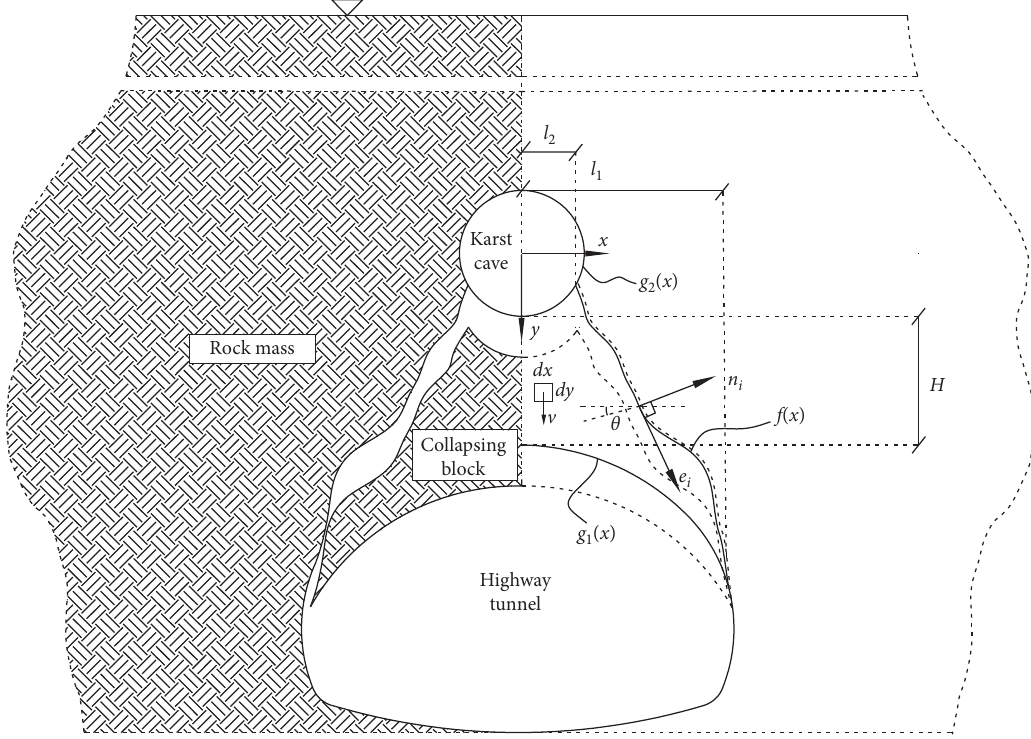
Figure 2: Collapse mechanism of a highway tunnel roof induced by a karst cave.